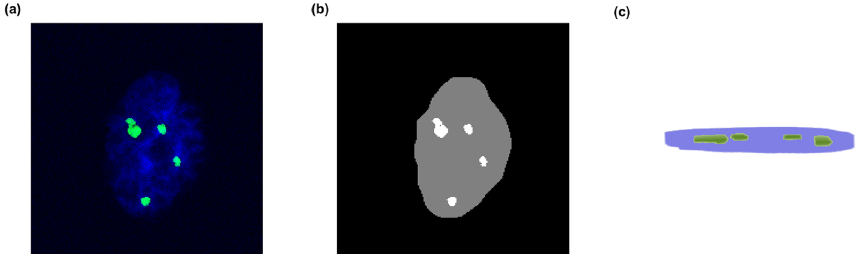
Fig. 9 Assessing the risk of missing foci when only a single plane centered in the cell nuclei is imaged. In ( a ), representative γH2AX foci in a single plane from the z‑stack are detected. Segmented foci ( b ) in a single plane and ( c ) a 3D representation of the detected foci in the full volume of the nucleus